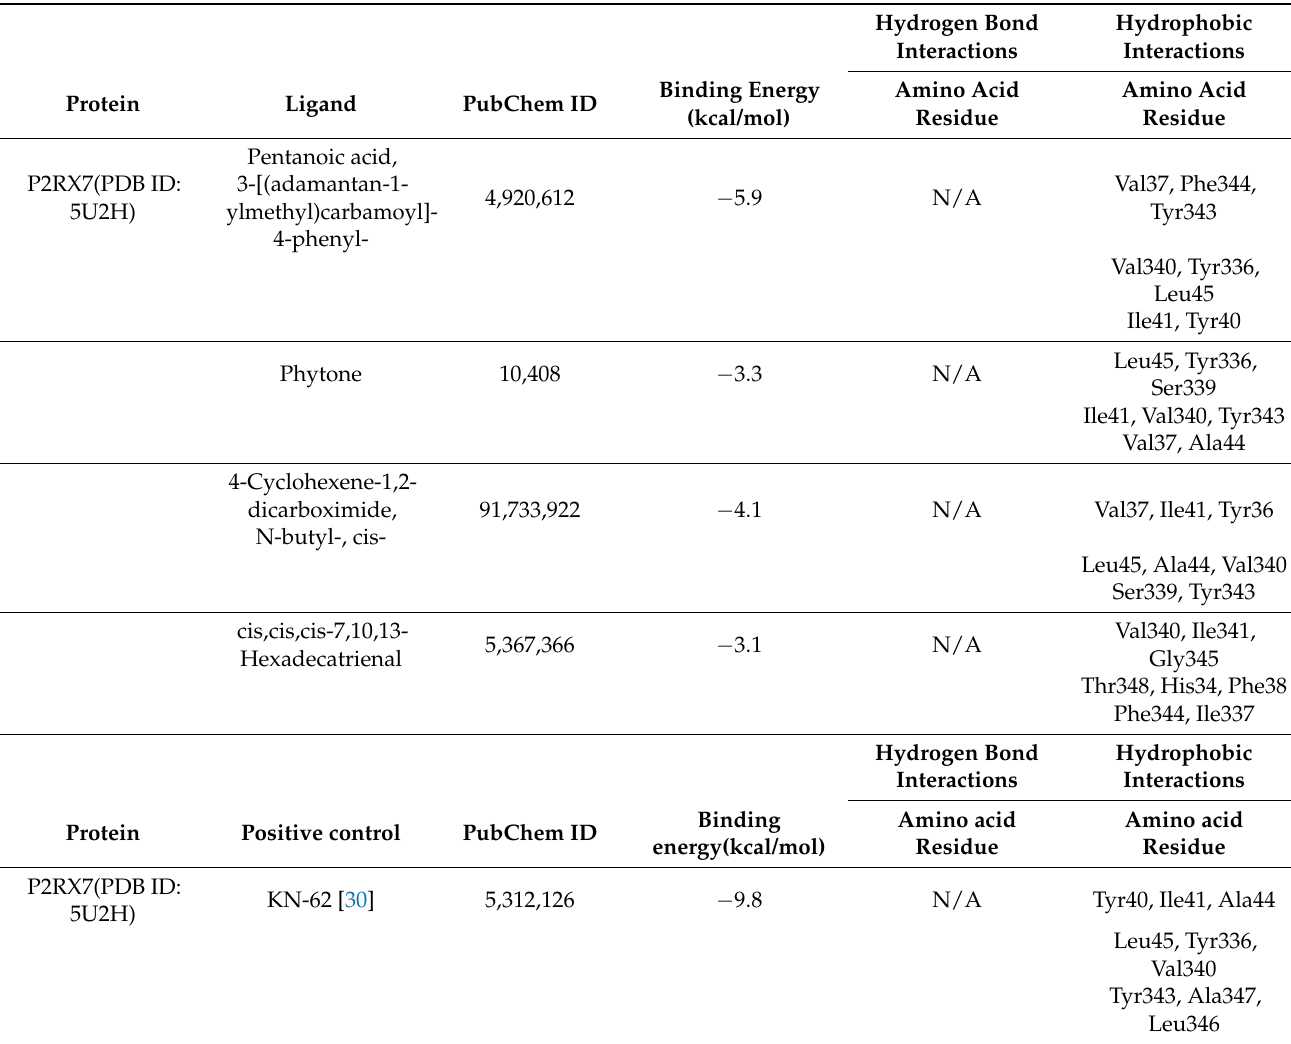
Table 7. Binding energy of potential compounds and a positive control on P2RX7 (PDB ID: